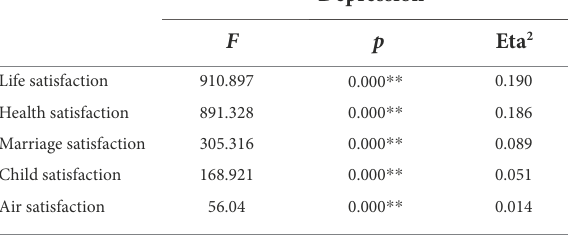
TABLE 6 ANOVA between the five dimensions of subjective well- being included and depression.